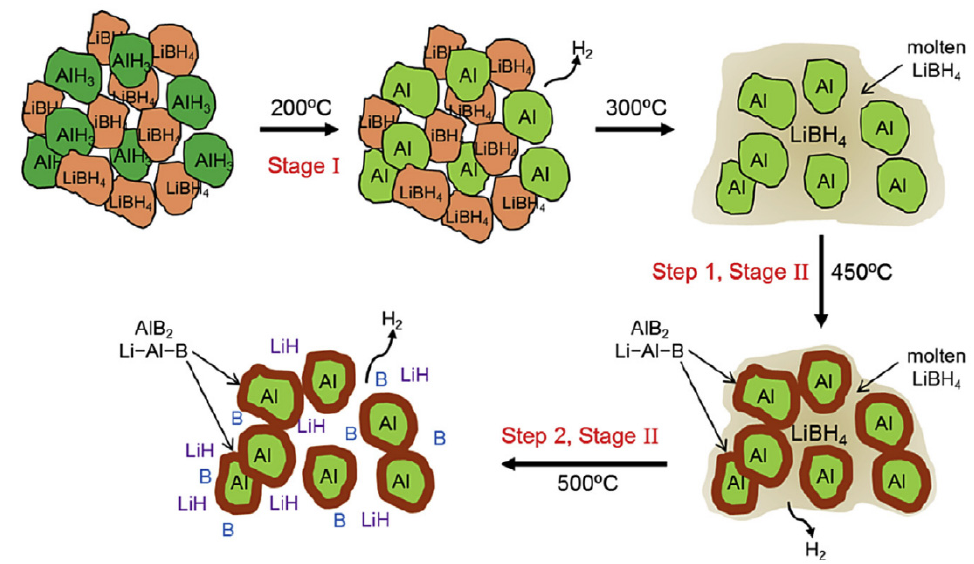
Figure 7. Microstructure evolution of a LiBH 4 /AlH 3 composite up to 500 °C, with a heating rate of 4 °C min − 1 . Reprinted with permission from [94]. Copyright (2016),